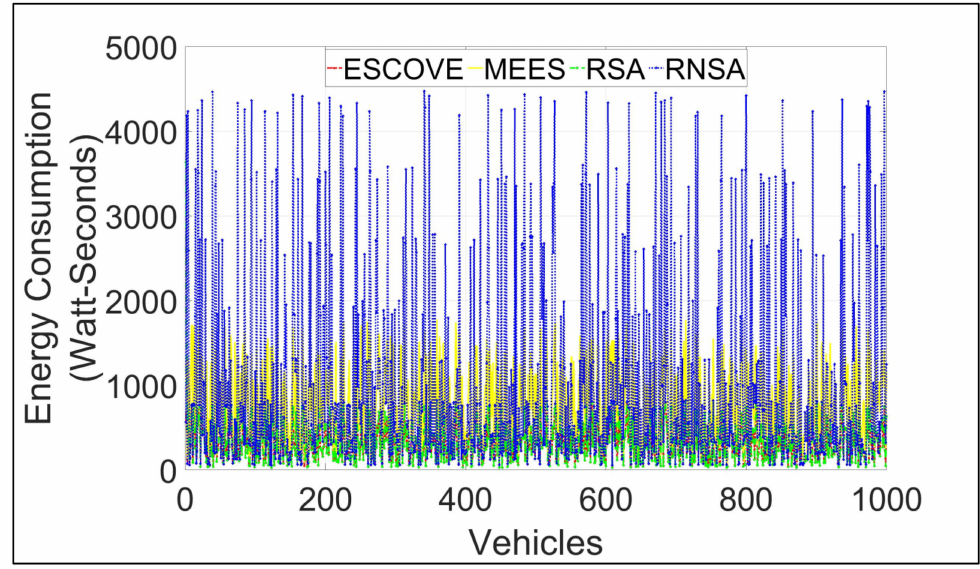
Figure 8. Energy consumption of requests using ESCOVE, MEES, RSA, and